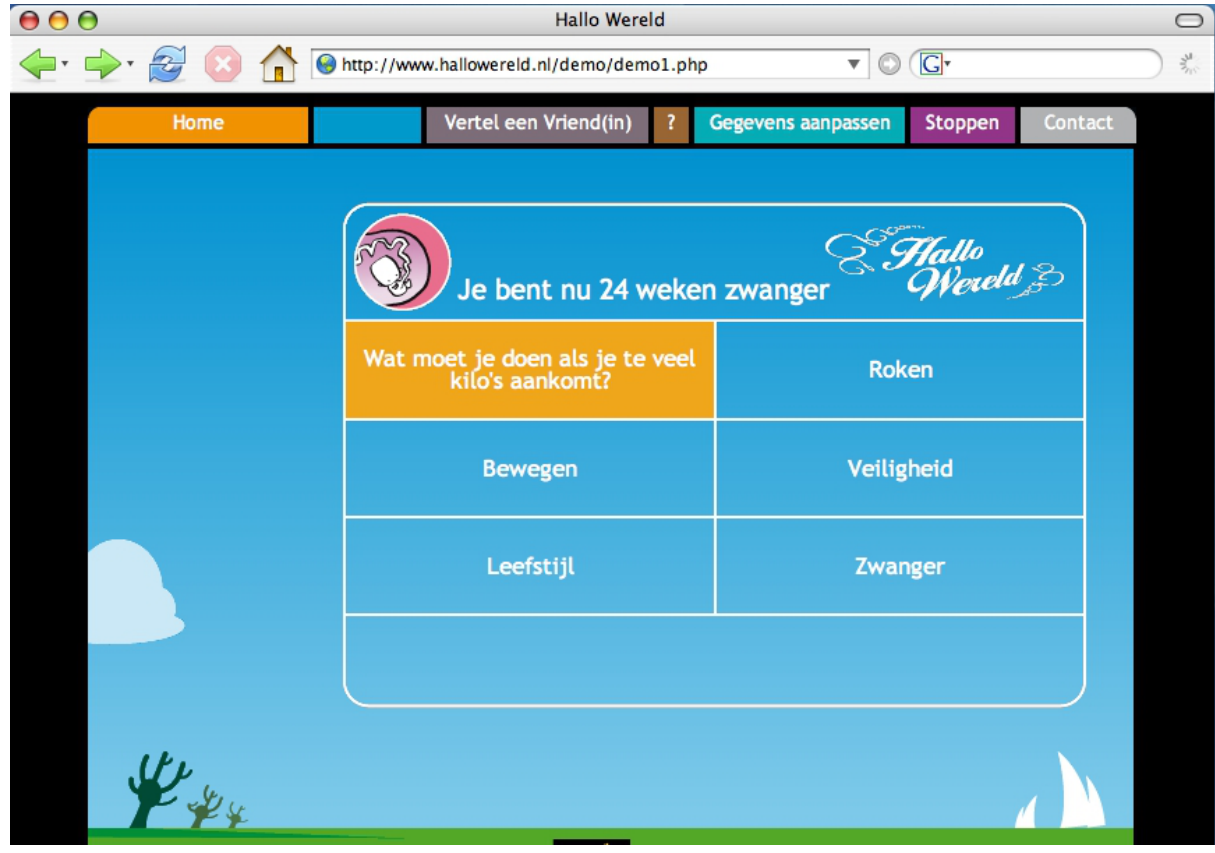
Figure 1. Screenshot of the quiz for week